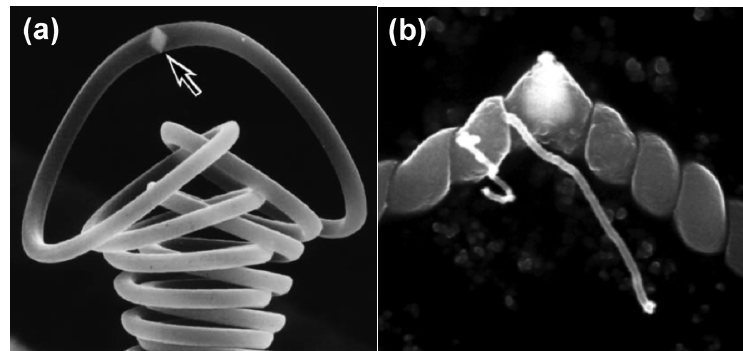
Figure 10. Growth tip of ( a ) a bidirectionally grown double helical carbon filament (b-DHCF) [44] and ( b ) a bidirectionally grown twisted carbon filament (b-TCF) [27]. The white tips on the top are the catalytic grains. Reprinted with permission from [27,44], Copyright 2003 Elsevier and Copyright 2002